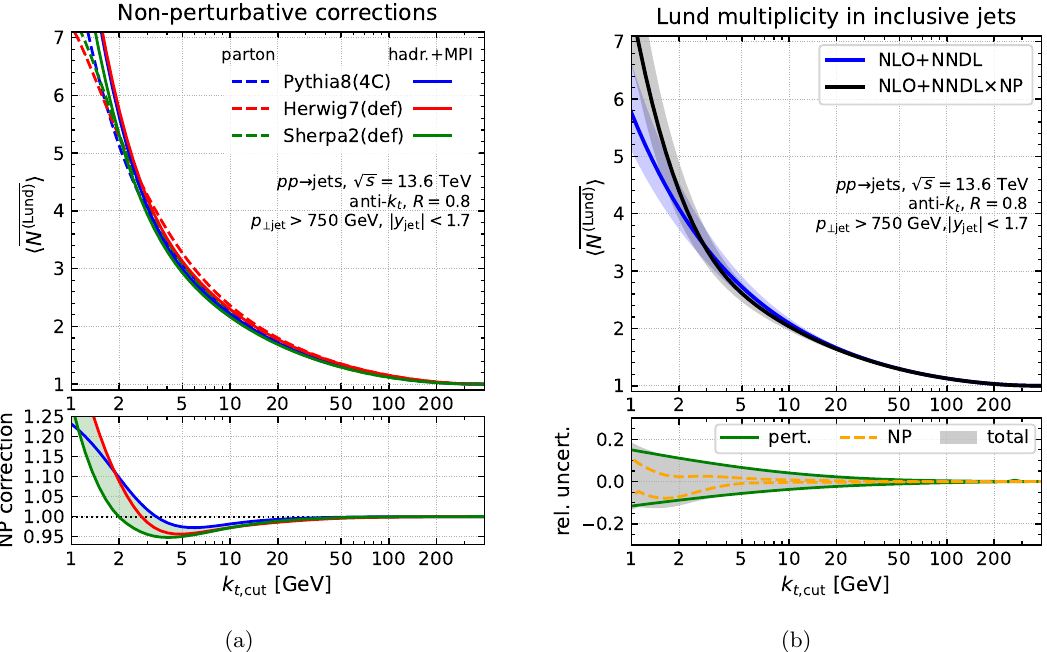
Figure 8 . Left: Lund multiplicity distributions obtained from Monte Carlo simulations (upper panel) together with the hadron+MPI/parton ratio (lower panel) used as our estimate of the non-perturbative corrections. Results are shown for Pythia8 (with the 4C tune), Sherpa2 and Herwig7 (with their default tune). The (green) shaded area in the bottom panel corresponds to the envelope of the individual non-perturbative corrections. Right: prediction for the average Lund multiplicity in LHC high-energy jets. The matched NNDL +NLO perturbative results are showed both with (black) and without (blue) non-perturbative corrections. The bottom panel displays the breakdown of uncertainties in their perturbative and non-perturbative